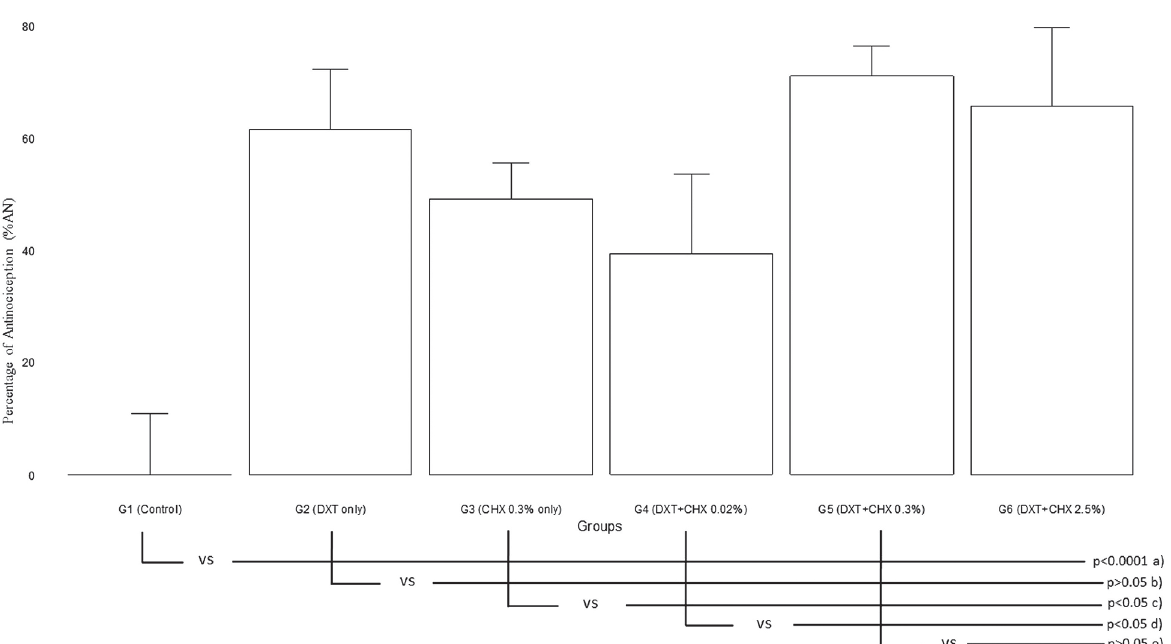
FIGURE 2 - Antinociceptive effects (%AN) of control and experimental groups in the first phase of formalin test. Data are present in Mean±S.E.M. of n=6 rats for each group. The letters represent the planned contrast ANOVA: a) G1 vs G2, G3, G4, G5, G6; b) G2 vs G3, G4, G5, G6; c) G3 vs G4, G5, G6; d) G4 vs G5, G6 and e) G5 vs